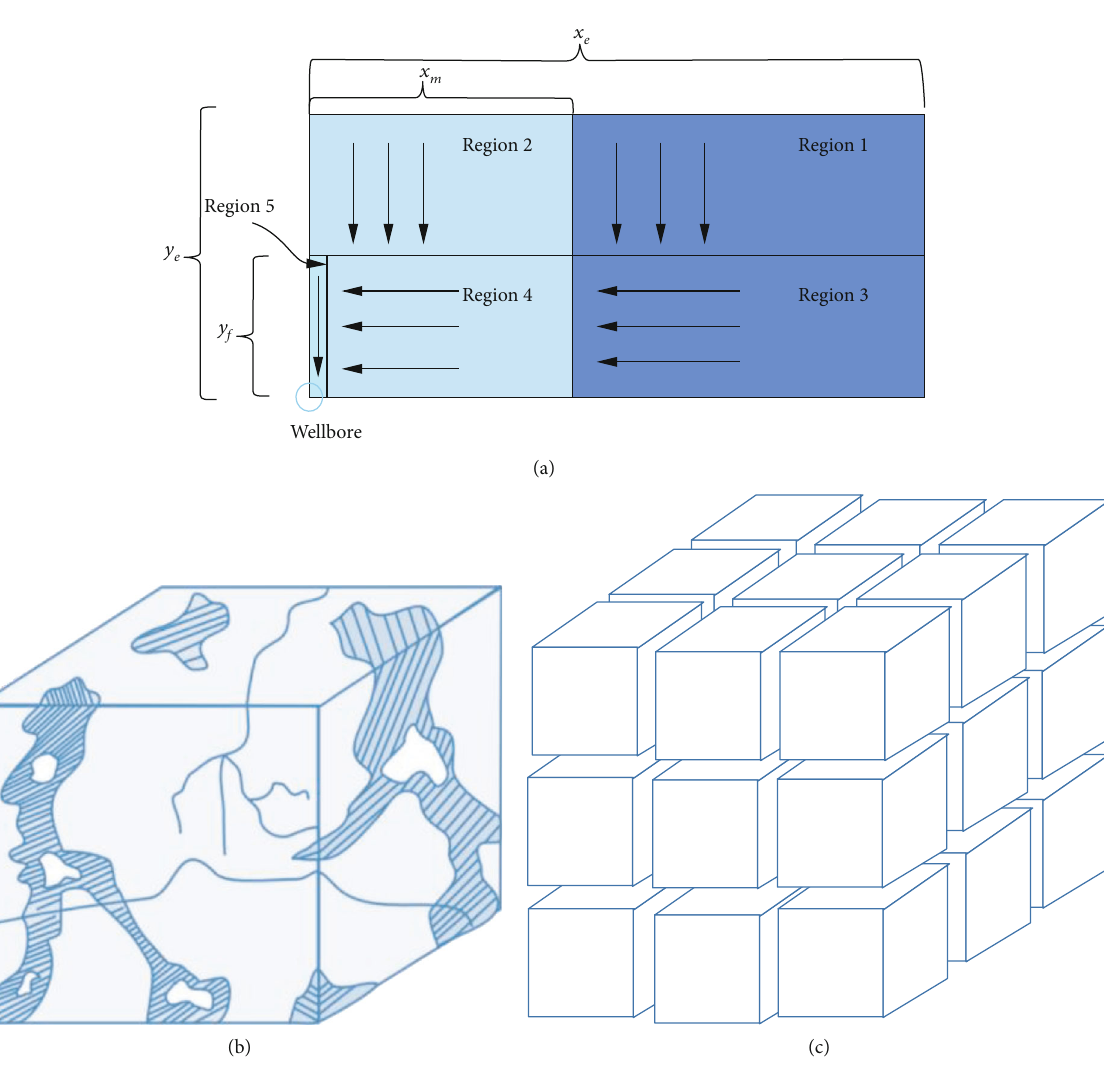
Figure 1: (a) Schematic of the fi ve-linear fl ow model representing fi ve continuous fl ow regions for a vertical well with an SRV region. (b) The matrix of SRV regions. (c) Classic Warren-Root dual-porosity medium